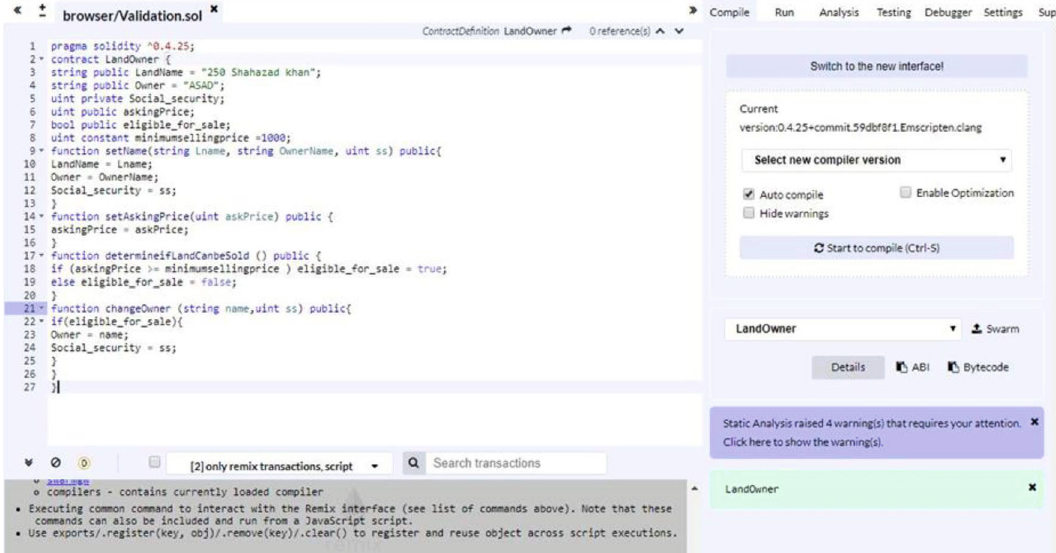
Figure 13: Validation environment.